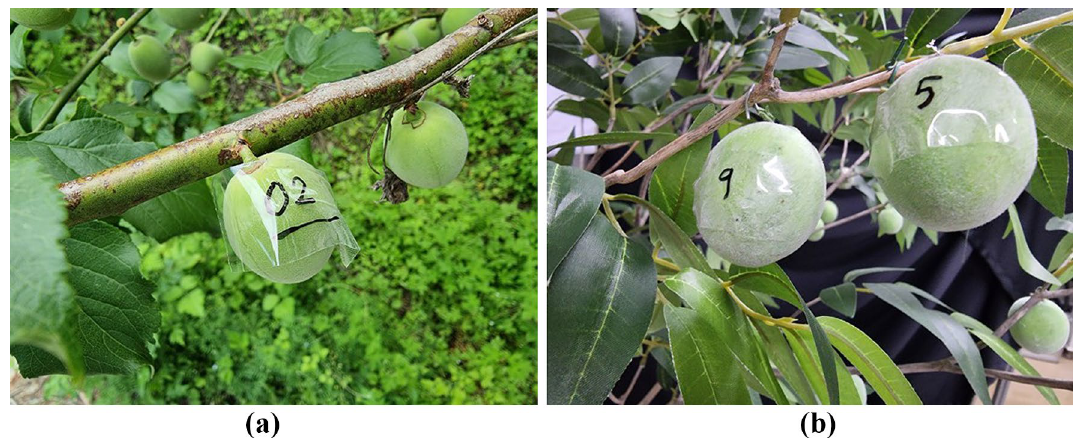
Figure 11. Numbering each prunus mume fruit: ( a ) actual outdoor fruits; ( b ) indoor artificial testing, and their average diameter (long axis) was 34 mm. An artificial Prunus mume tree for estimating growth stages was constructed, as shown in Fig. 10b, and the artificial Prunus mume fruits in Fig. 10a were evenly hung on a 2.1 m high tree. To evaluate the performance of the developed algorithm with an artificially constructed Prunus mume tree indoors, data were acquired as similar as possible to the imaging conditions at outdoor Prunus mume